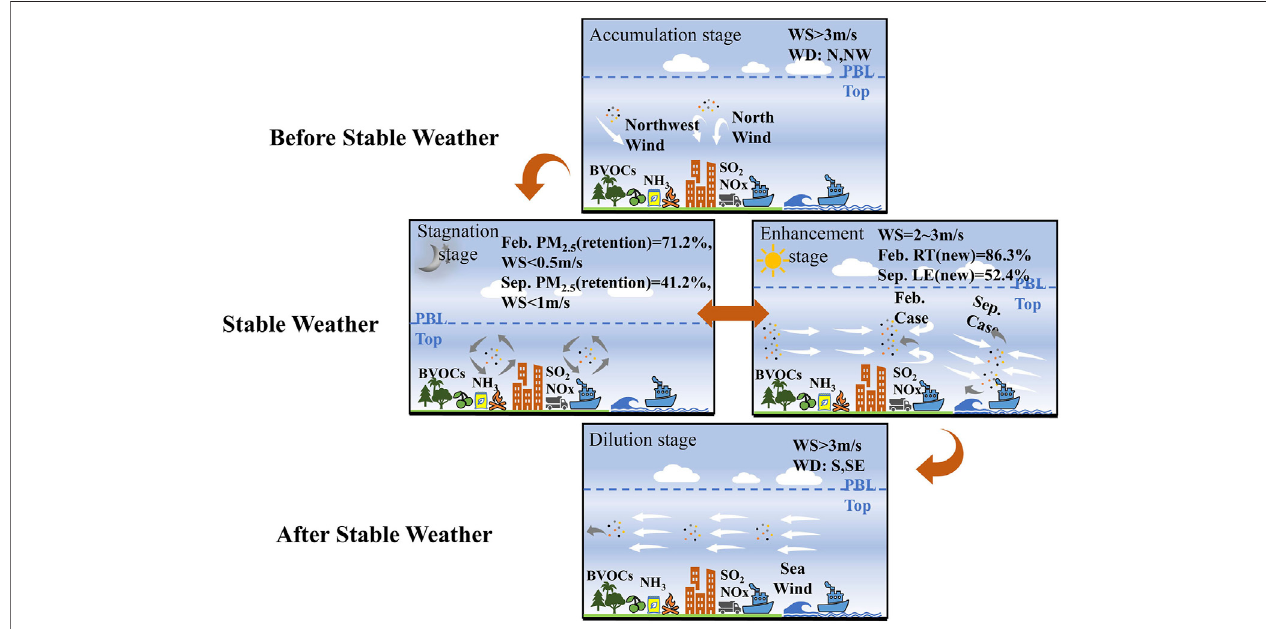
FIGURE 10 | The diagrammatic sketch of PM 2.5 pollution process in stable